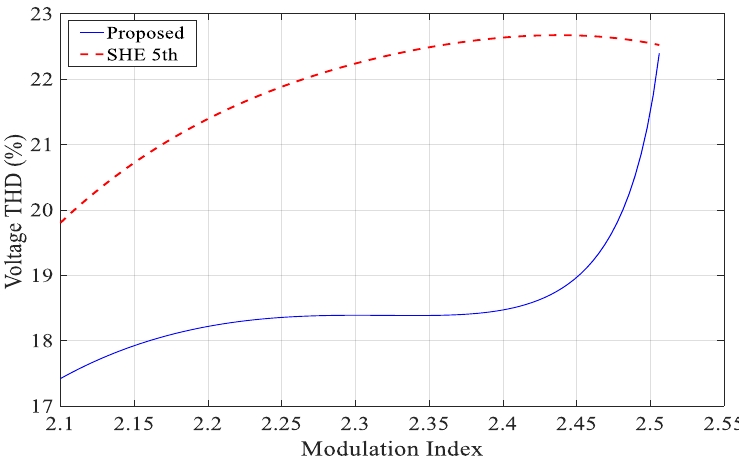
Figure 8. Curve showing variation between the Voltage THD in percent and modulation index for SHE of 5th order harmonics and for the proposed technique.